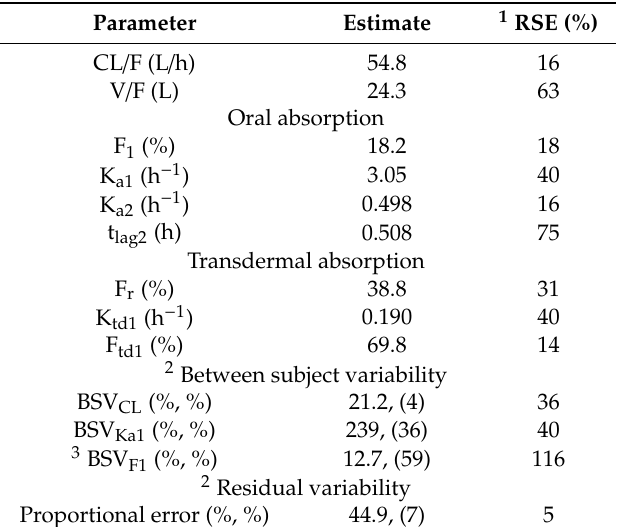
Table 1. Pharmacokinetic parameters of the final